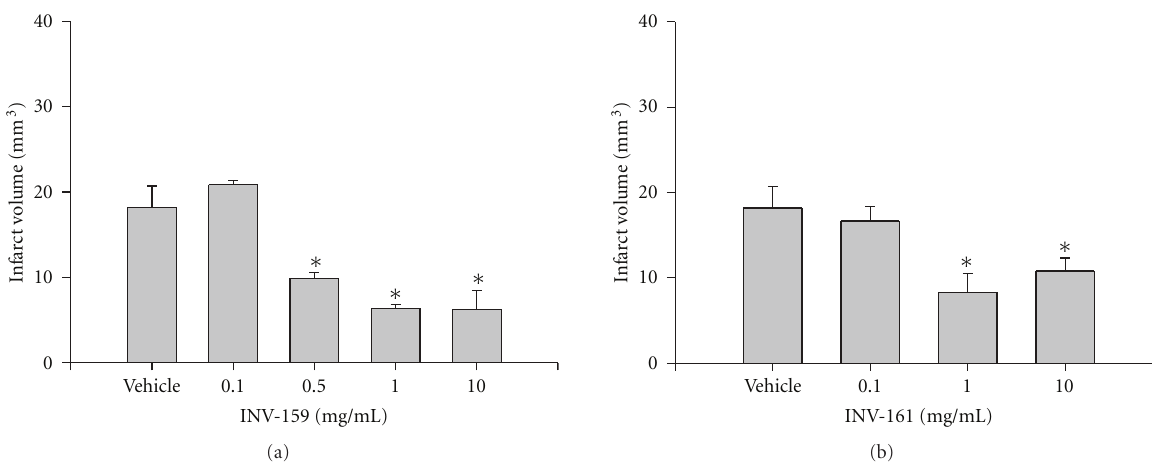
Figure 4: (a) E ff ect of pretreatment with either 2% sodium bicarbonate (vehicle), INV-159, or INV-161 (b) on infarct volume (mm 3 ) calculated from TTC-stained 1mm thick coronal sections throughout the extent of the infarct following I/R. Each bar represents the mean ± S.E.M. and ∗ indicates significance ( P ≤ 0 . 05) from the vehicle control group ( n = 4-5/group).